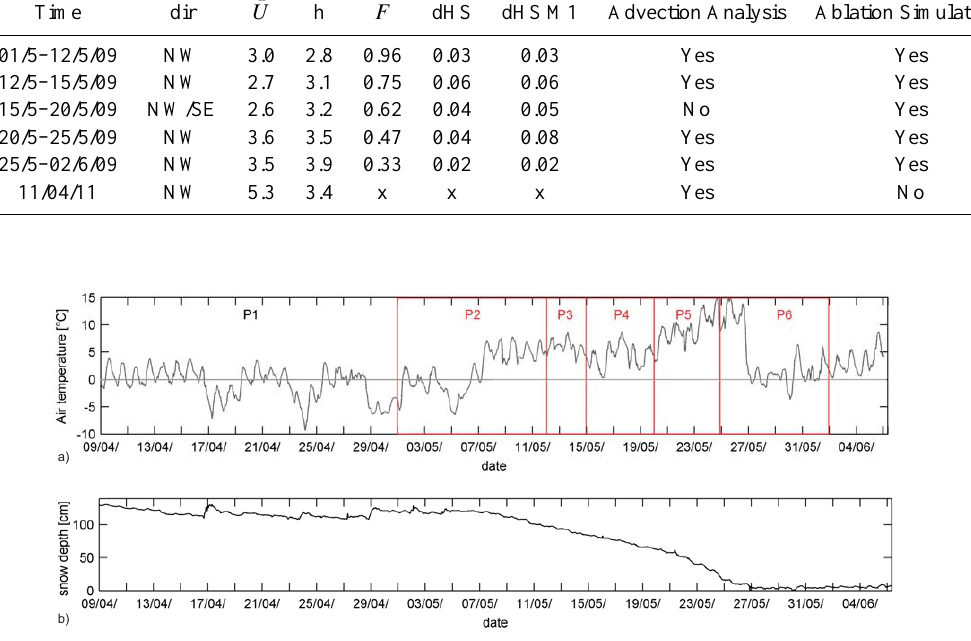
velocity ( ¯ U ) and the modeled snow-coverage ( F ) at the start of the respective ablation period are also shown in Table